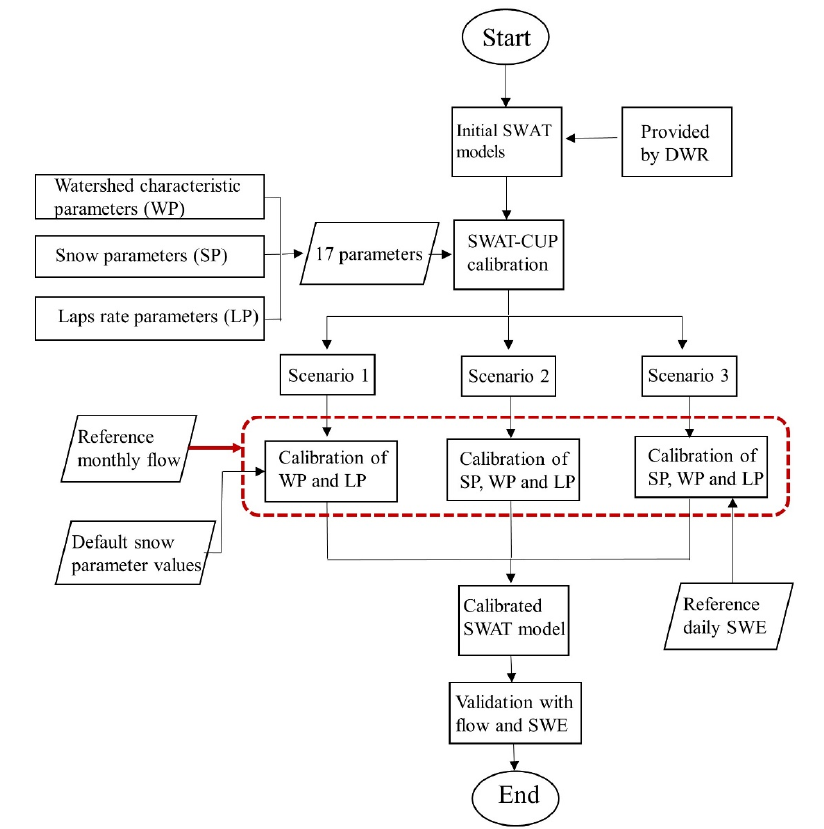
Figure 2. Flow chart for the three calibration strategies. SWAT-CUP: Soil and Water Assessment Tool-Calibration and Uncertainty Program and DWR: Department of Water Resource.